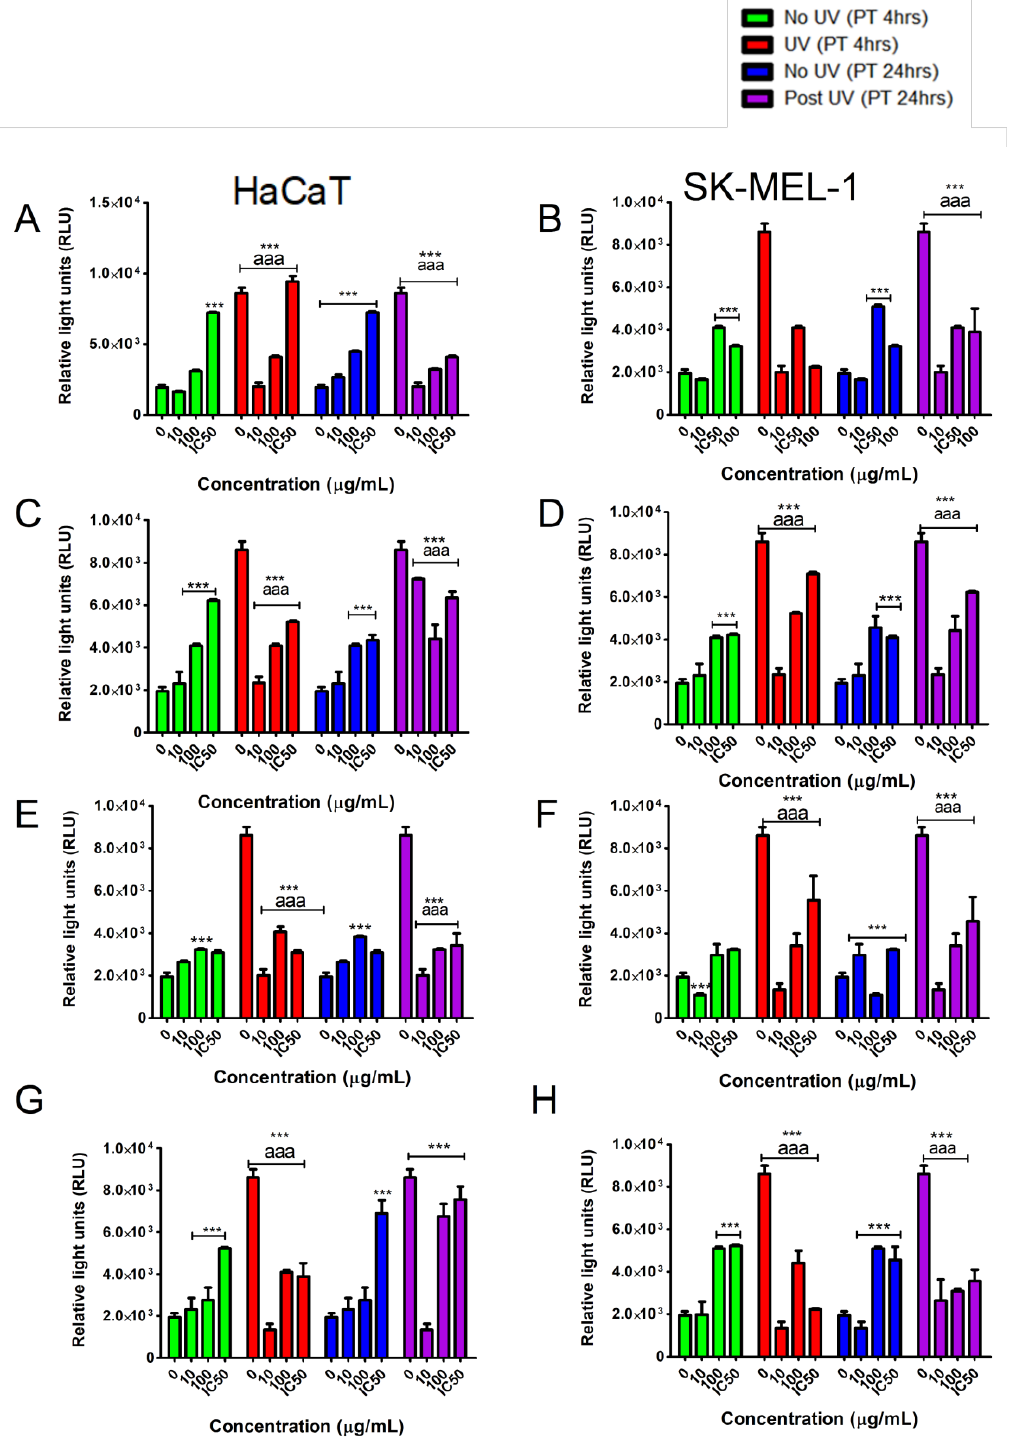
Figure 6. Pre-treatment with tested samples [TE ( A , B ); compound 1 ( C , D ); compound 2 ( E , F ); compound 3 ( G , H )] effects in caspase 3 activation in skin cells exposed to UVB irradiation. Vertical lines indicate standard deviation. *** p < 0.001 control vs. experimental concentrations; aaa p < 0.001 No UVB irradiation vs. UVB irradiation for experimental concentrations. Further evaluation of the cytotoxic potential of the test compounds revealed toxicity only at the highest concentrations tested in both cell lines. This was indicated by elevated fluorescence detected in dead cells (Figure 7). In combination with UVB irradiation, the tested samples induced marked decrease to cytotoxicity at low concentrations. Thus,